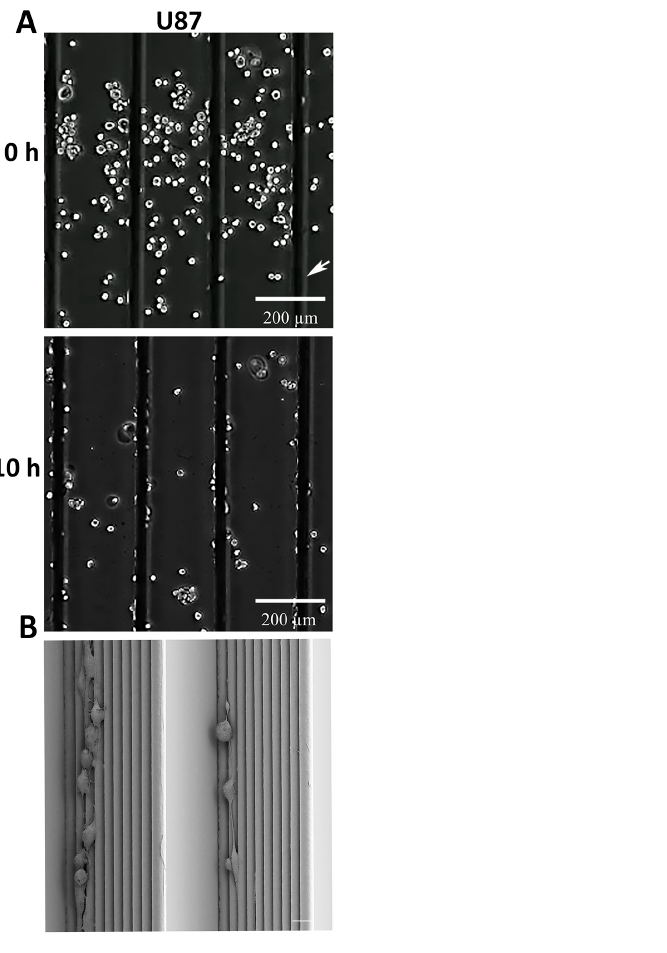
Figure 3. U87 durotaxis and cell migration with aligned microfibers. ( A ) Representative images of U87 cells on laminin-coated aligned microfibers at 0 h and 10 h; scale bar = 200 µ m. ( B ) Representative scanning electron microscopy image of U87 cells on stacked aligned microfibers (total of 10 melt electrowritten printed fibers: scale bar = 20 µ